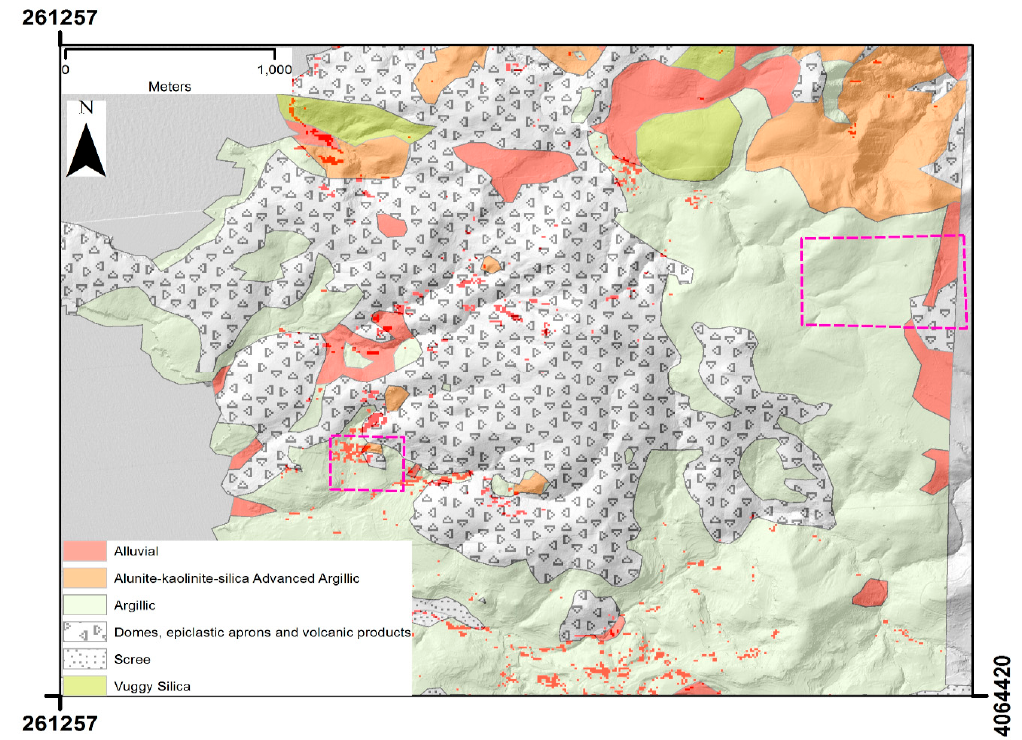
Figure 8. Results of MPM modelling overlain by field mapped hydrothermal alteration zones adapted from [38] underlain by a DEM. Red pixels indicate pixels with high values of modelled mineral prospectivity.